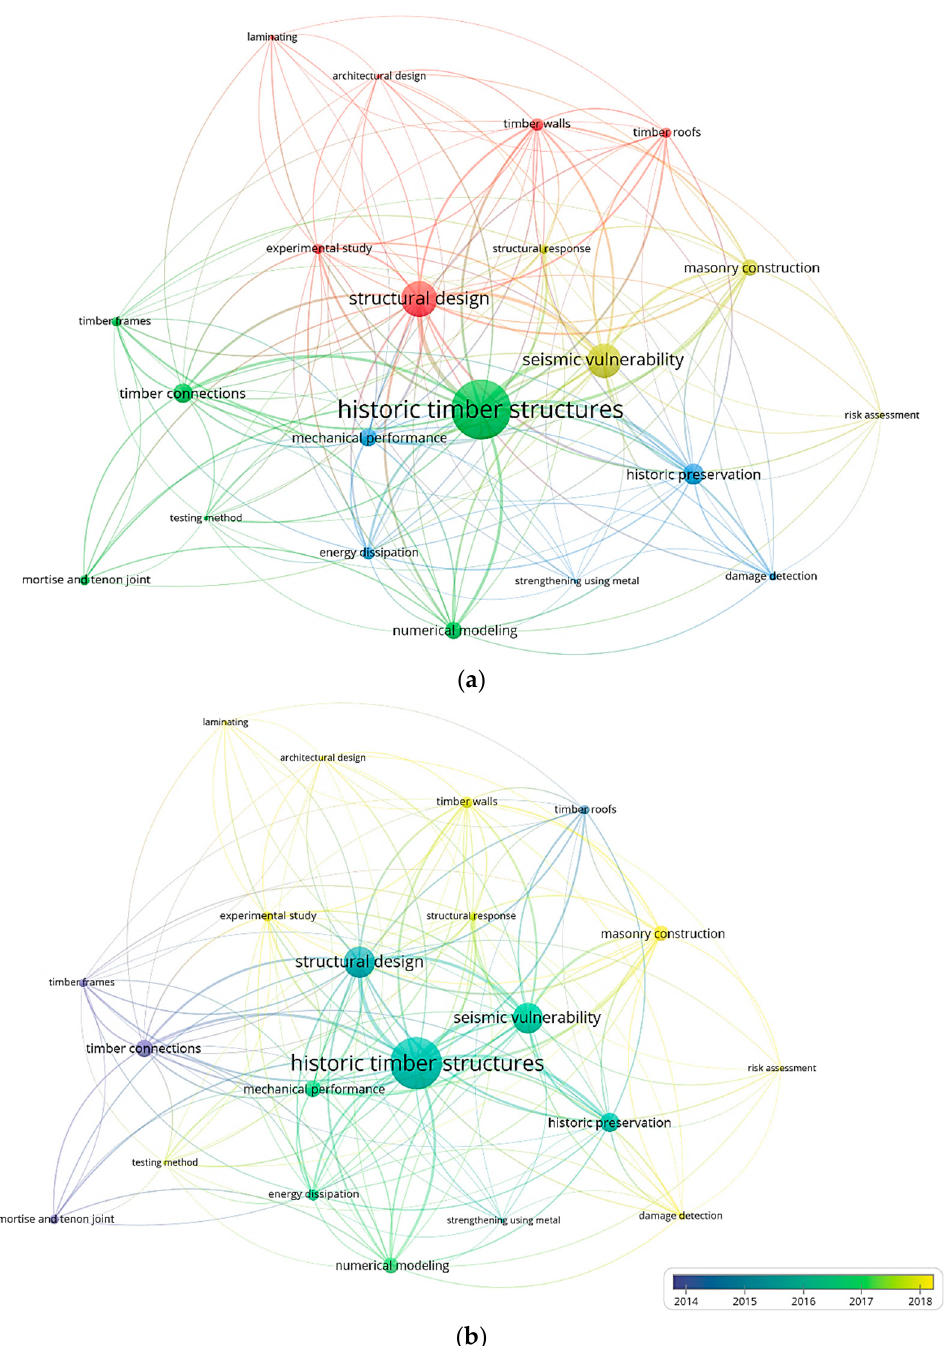
Figure 7. ( a ) Frequency keywords clustering. ( b ) Trending research topic from blue (oldest) to yellow (newest).